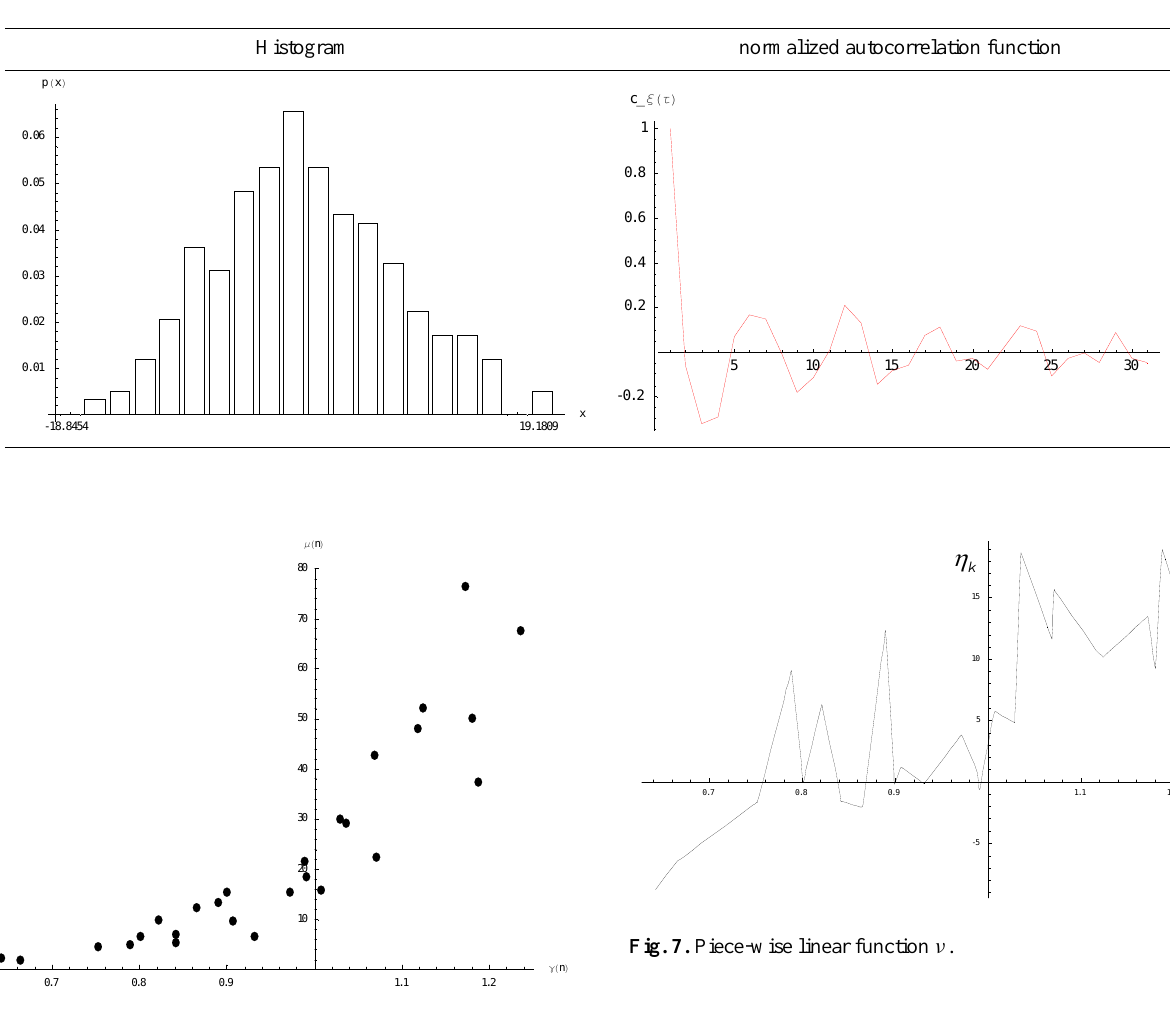
Fig. 6. Scatterplot of the ( γ n , µ n ) pairs for available values n = − 4, ..., 23. The points display a distinctive trend which allows one to derive a least-squares relation between those two parameters.